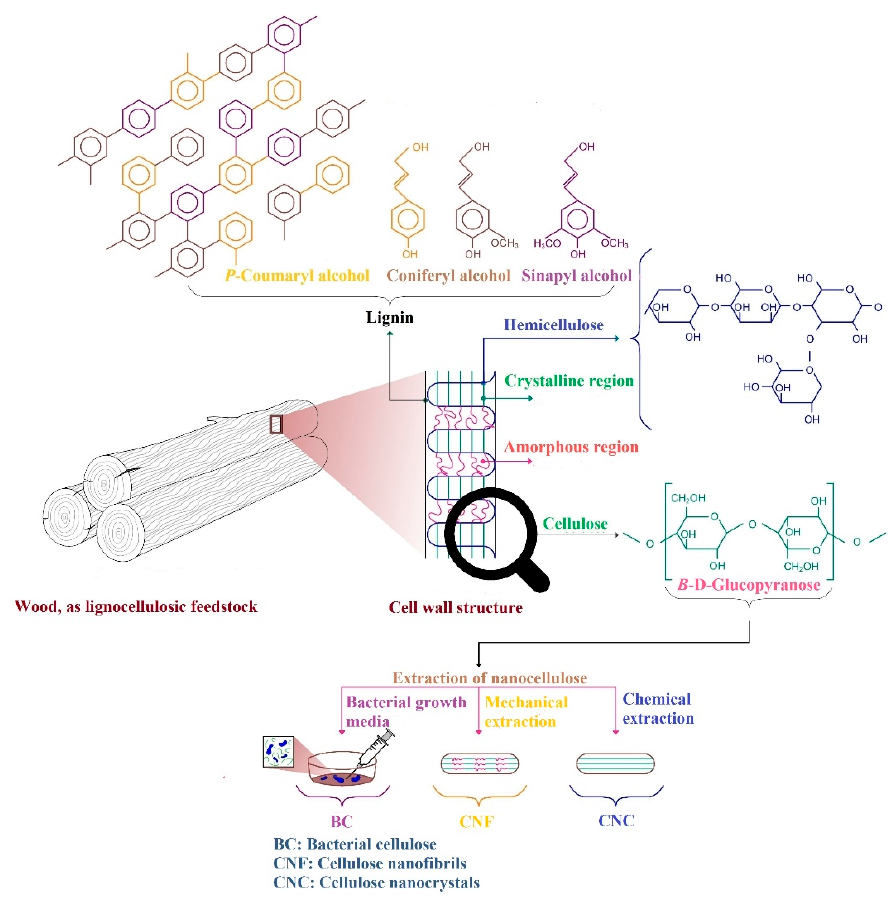
Figure 4. A schematic of cellulose biopolymer derivation from wood, which is converted to CNF, CNC, or BC, as the three major nanoscale forms of cellulose.